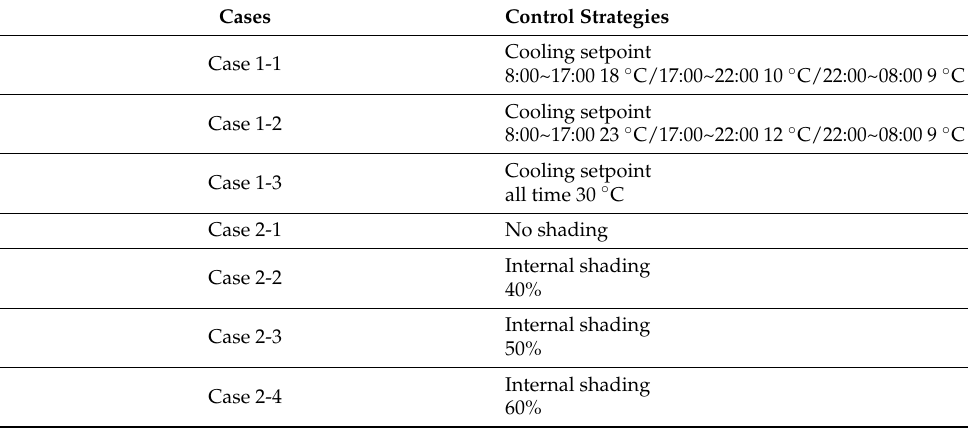
Table 6. Control strategies of smart farm.